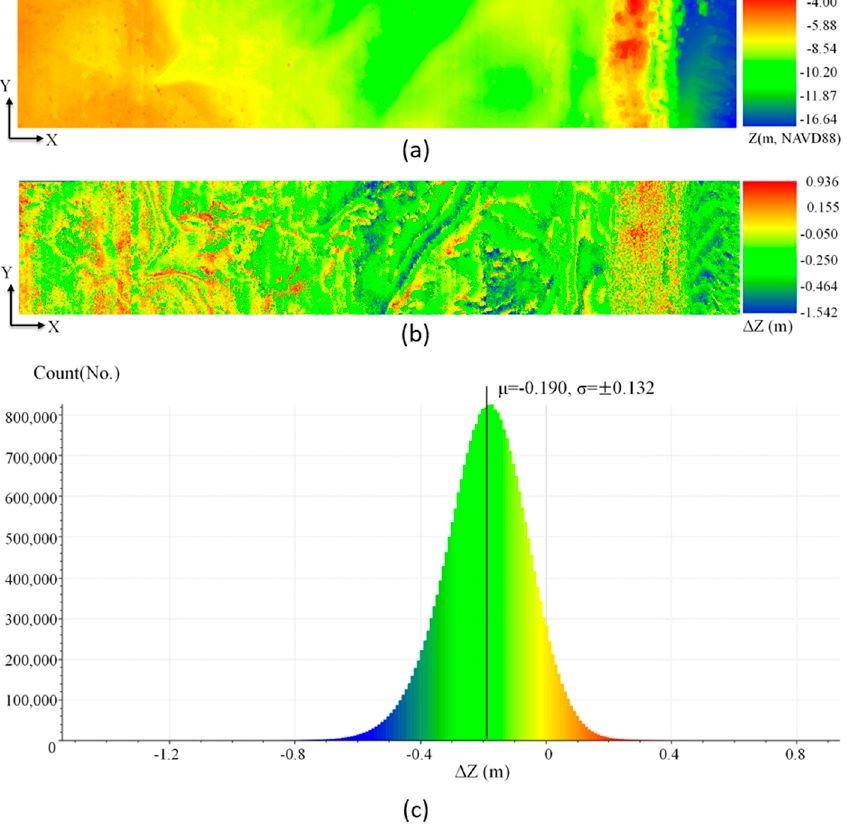
Figure 9. Error distribution in the z-direction ( ∆ z) of Virginia dataset # 1; ( a ) MBES data of Virginia test site # 1 ( b ) The difference map of ∆ z ( c ) Frequency histogram of ∆ z ( µ − 3 σ < ∆ z < µ + 3 σ ).